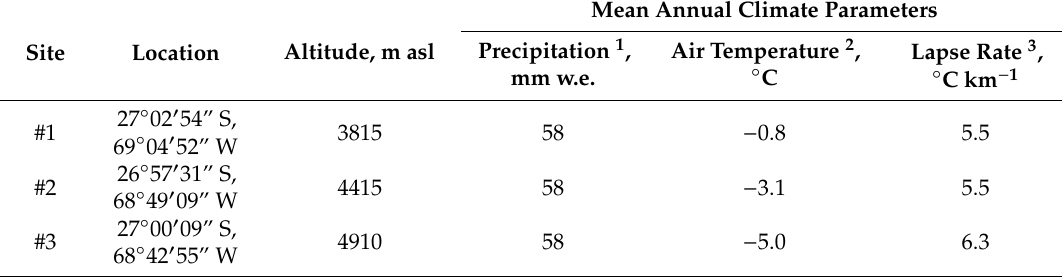
Table 1. Validation sites, their locations, and local climate. Precipitation data are too low resolution to show di ff erences among the